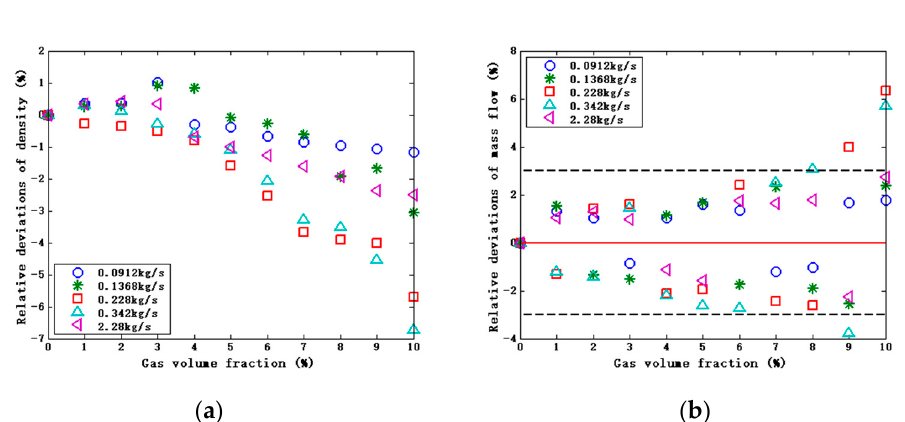
Figure 7. The original deviations of stratified flow relative to GVF before correction. ( a ) Relative deviations of density. ( b ) Relative deviations of mass flow.